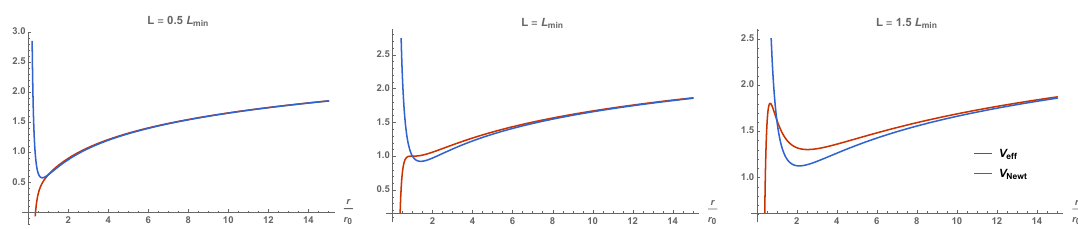
Figure 1 . E(cid:11)ective GR and Newtonian potentials for GM = 1 = 2 and di(cid:11)erent values of the angular momentum L . We can clearly observe that for L < L min the GR potential has no maximum, at L = L min it develops an in(cid:13)ection point, and for L > L min a maximum occurs and we can have stable orbits. On the other hand, the shape of the Newtonian potential stays unchanged and always allows stable